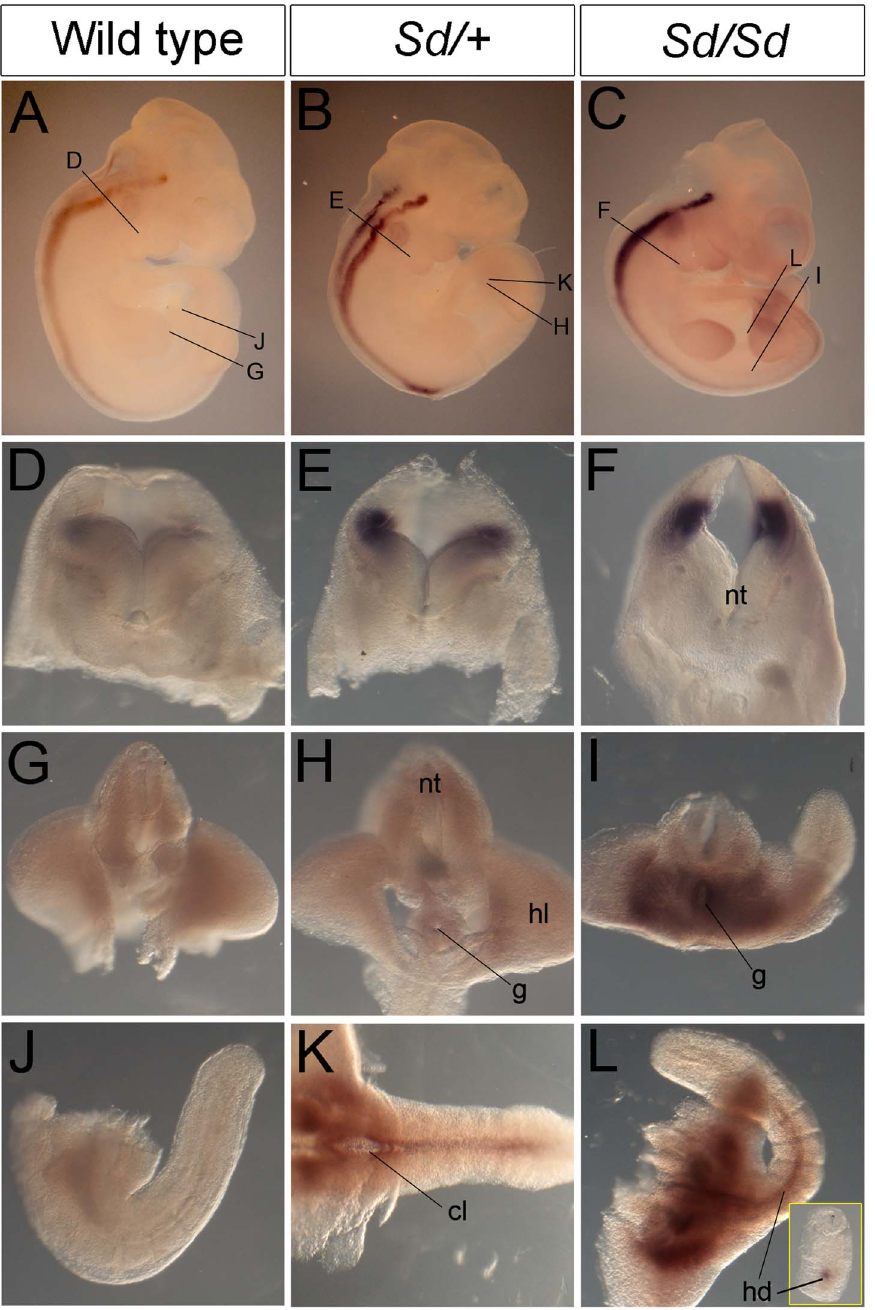
Figure 4. Ptf1a expression in wild-type, Sd/ + , and Sd/Sd embryos at E10.5. (A–C) Whole mount ISH showing Ptf1a expression in wild type, Sd/ + and Sd/Sd . embryos at E10.5. Ptf1a expression is seen in the hindbrain and throughout most of the neural tube. Lines indicate corresponding slices in D–I. (D–I) Slices from embryos in A–C showing Ptf1a expression at the level of hindbrain (D–F), hindlimb (G–I). (J–L) Isolated tails show ectopic expression of Ptf1a in the hindgut diverticulum (hd) in K,L. Inset in L is a slice close to the end of the tail showing expression in the hindgut diverticulum. Ectopic expression of Ptf1a is seen around the cloacal opening (cl) in K. nt-neural tube, g-gut, hl-hind limb.